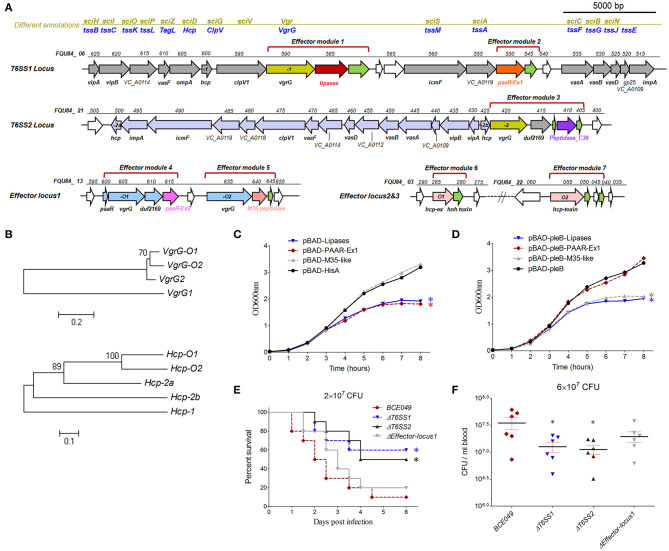
The role of T6SSs and predicted effectors in interbacterial competition and pathogenicity. (A) Schematic diagram of the genetic organization in two T6SS loci and three predicted effector loci. (B) The evolutionary relationships among VgrGs encoded within effector locus1 and T6SS loci in strain BCE049 (upper panel), and among Hcps encoded within effector locus2, locus3, and T6SS loci (lower panel). The protein sequences were aligned with ClustalW, and the MEGA software version 5.0 was used to perform a 1,000-bootstrap phylogenetic analysis using the neighbor joining method. (C,D) Growth curves of E. coli cells producing lipase, PAAR-Ex1 and M35-peptidase using pBAD-hisA or pBAD-pleB plasmids. The periplasmic localization of proteins using plasmid pBAD-pleB was achieved by fusion to the PelB leader sequence (48). The cultures were induced by l-arabinose at the indicated time (shown by the red arrow). The experiments were run in triplicate. The data were compared with that of strain with the vector pBAD-hisA or pBAD-pleB and analyzed using the one-way ANOVA test (*P < 0.05). (E) Effect of hlyCABD and CNF2 on ExPEC BCE049 pathogenicity. Survival curve of mice infected with 2 × 107 CFU/mouse bacteria (10 5-week-old mice per group). The data were compared with that of strain BCE049 and analyzed using the log-rank (Mantel–Cox) test (*P < 0.05). (F) Systemic infection experiments were conducted to assess bacterial proliferation in mouse blood. Bacterial reisolation from the blood at 12 h postinoculation was quantified by plate count. Statistical significance was determined by a Student t-test based on comparisons with the wild-type group (*P < 0.05).